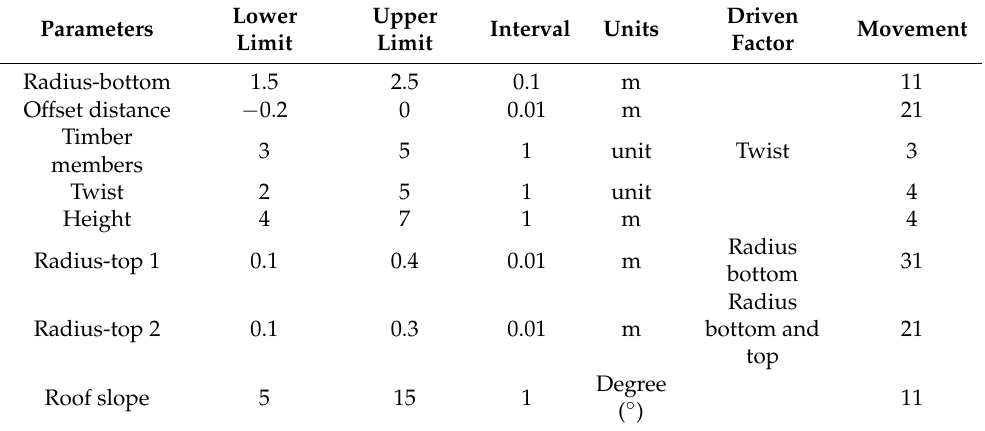
Table 1. The geometry